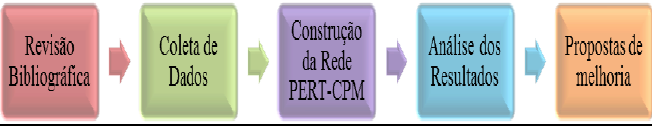
Figura 1: Etapas do Estudo. Fonte: Autores, (2018).